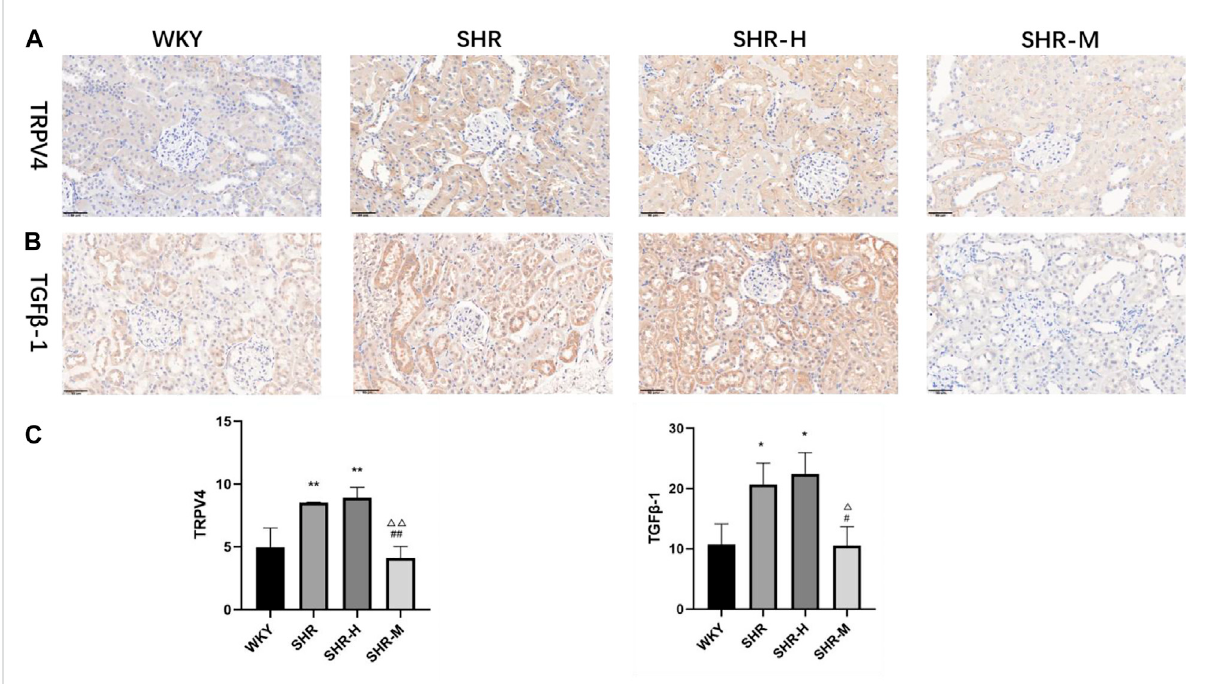
FIGURE 4 Effects of different intensity exercise training on related fi brotic molecules. (A,B) Immunohistochemical staining result and responding quanti fi cation of protein products of transient receptor potential vanilloid 4 (TRPV4) and transforming growth factor-beta (TGF β -1). (C) Bars represent the corresponding protein quanti fi cation of TRPV4 and TGF β -1. Values are mean ± S. D ( n = 3 in each group). * p < 0.05 and ** p < 0.01 versus the WKY group. △ p < 0.05 and △△ p < 0.01 versus the SHR group. # p < 0.05 and ## p < 0.01 versus the SHR-H